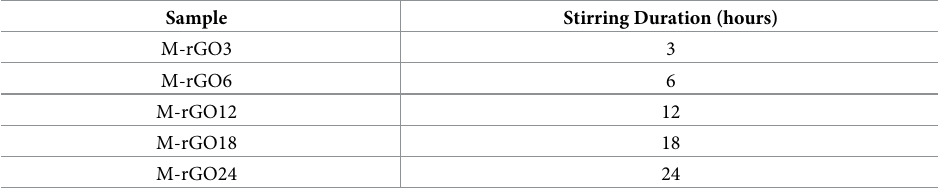
Table 1. Synthesis parameter and designations of